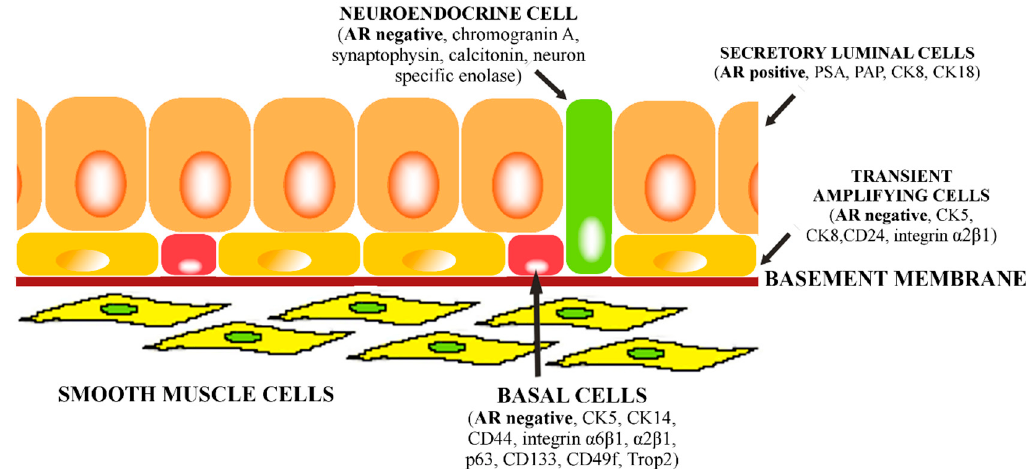
Figure 1. Schematic diagram of prostatic cellular compartments and their identity markers. Neuroendocrine cells are very rare cells located in the luminal epithelial